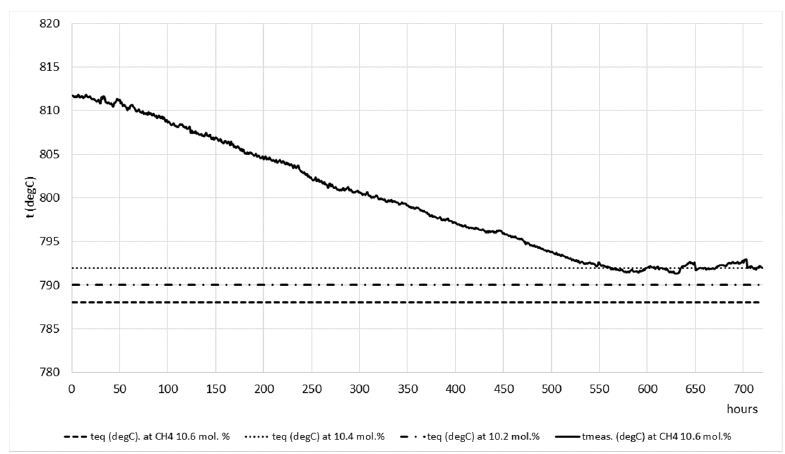
Figure 13. Catalyst outlet temperature readings regarding equilibrium temperature at outlet methane molar concentrations of 10.6, 10.4, and 10.2 mol. %.